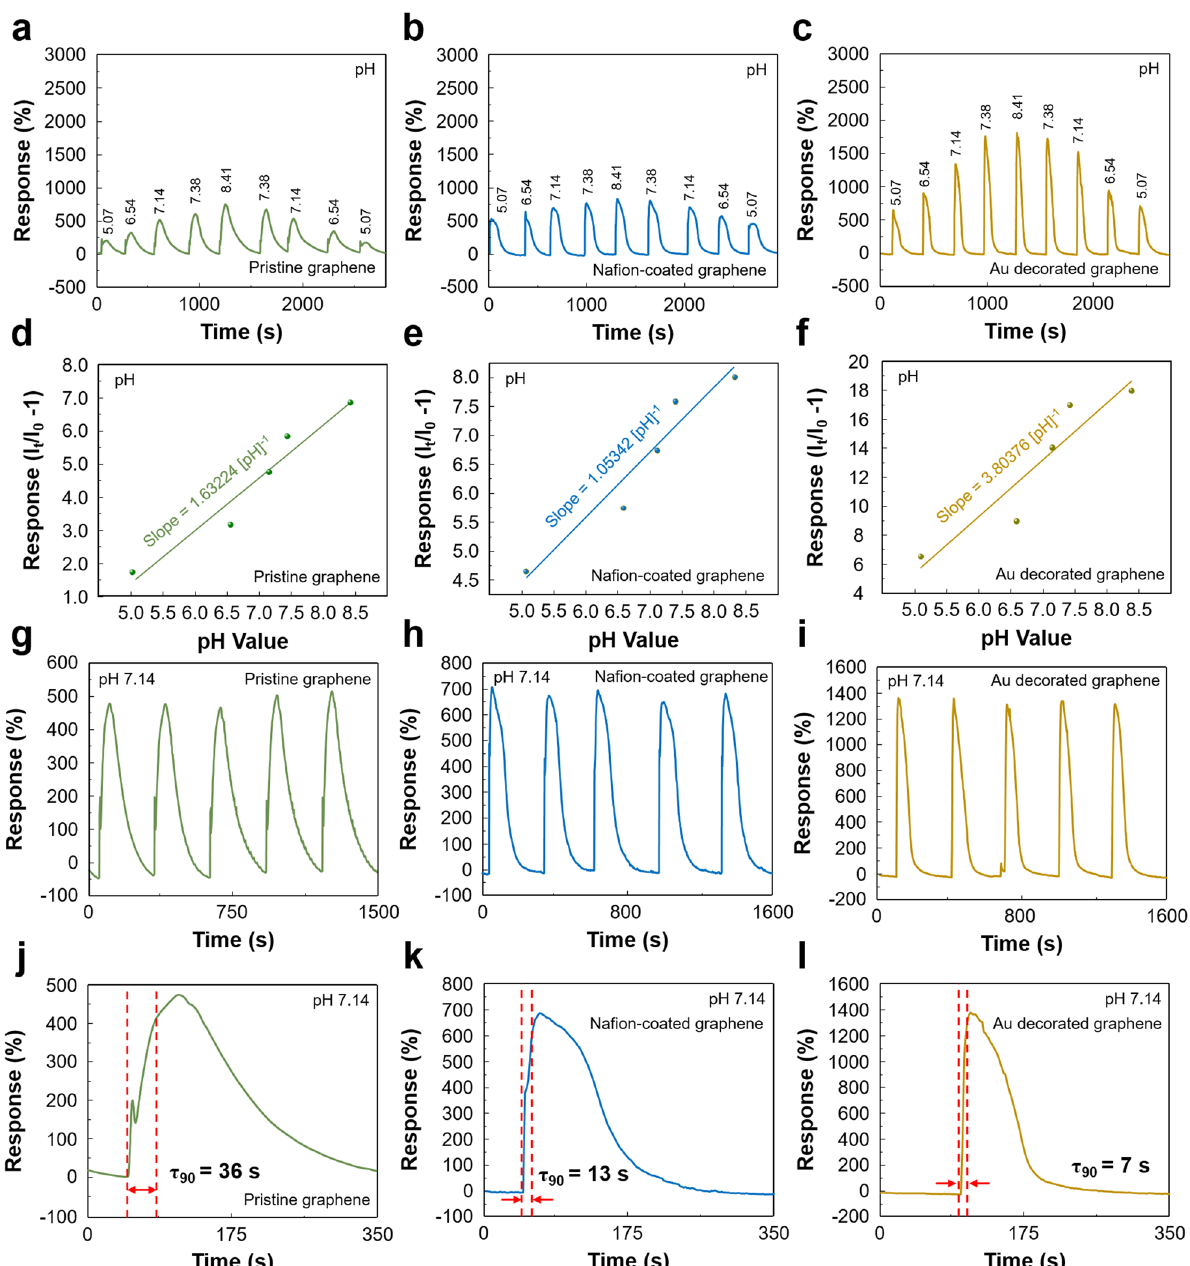
Fig. 3 pH detection characteristics of the graphene SFETs. pH detection of a pristine graphene, b Na fi on-coated graphene, c Au-decorated graphene, and d – f linearity of pristine graphene, Na fi on-coated graphene, and Au-decorated graphene by pH value vs. response. Repetitive test of pH 7.14 solution response of g pristine graphene, h Na fi on-coated graphene, and i Au-decorated graphene. The τ 90 values of response to pH 7.14 solution of j pristine graphene, k Na fi on-coated graphene, and l Au-decorated